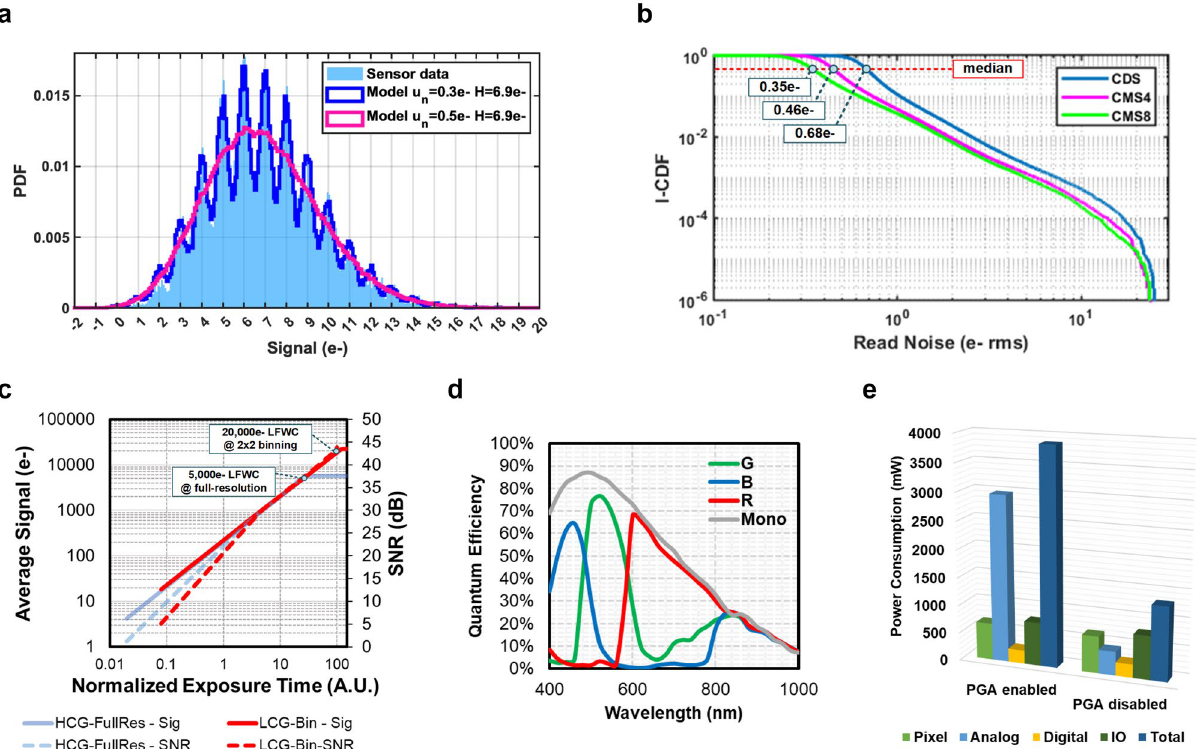
Figure 4. Key sensor performance. ( a ) Photon counting histogram formed with the data from one pixel in 12,000 frames. The sensor data is well aligned with the distribution predicted by the theoretical Poisson- Gaussian model with 6.9e- average signal and 0.3e- read noise. The results are also compared with a model response of a sensor with 0.5e- read noise (e.g., sCMOS sensor), and the model shows no distinctive photon quantization or photon number resolving capability. ( b ) Inverse cumulative density function (I-CDF) of read noise distribution across the pixel array with CDS, CMS4, and CMS8 readout. ( c ) Average signal and signal-to- noise ratio vs. normalized exposure time under HCG and LCG modes with full resolution and 2 × 2 binning. ( d ) Quantum efficiency curves of the sensor in RGB channels from 400 to 1000 nm. ( e ) Distribution of power consumption in different domains on the sensor with PGA enabled and